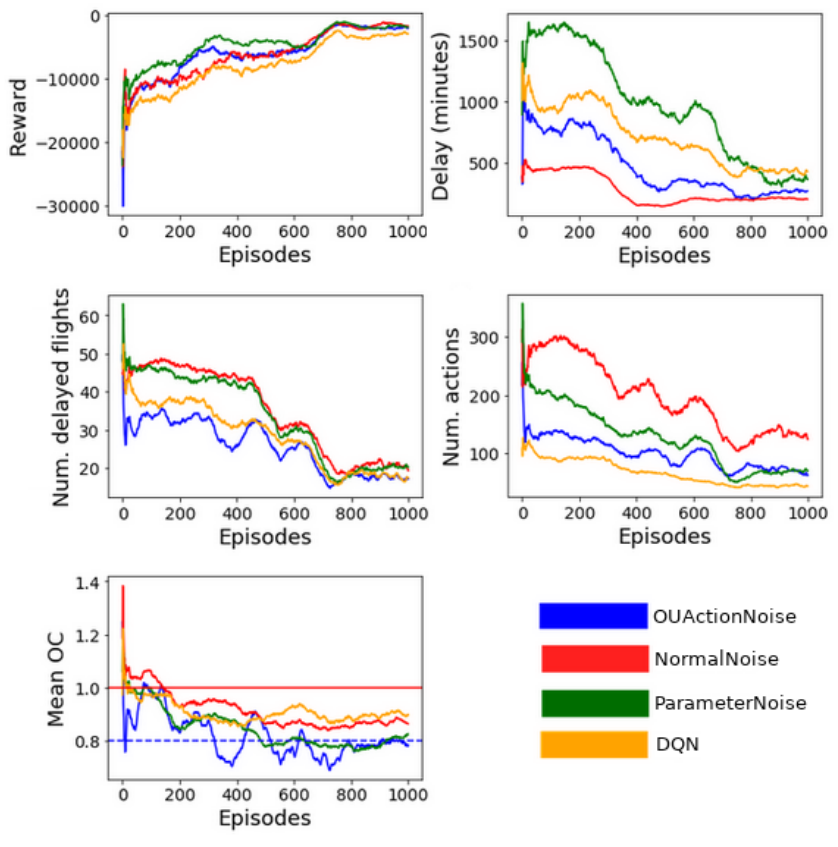
Figure 3. Trends KPIs used to evaluate the performances of the RL